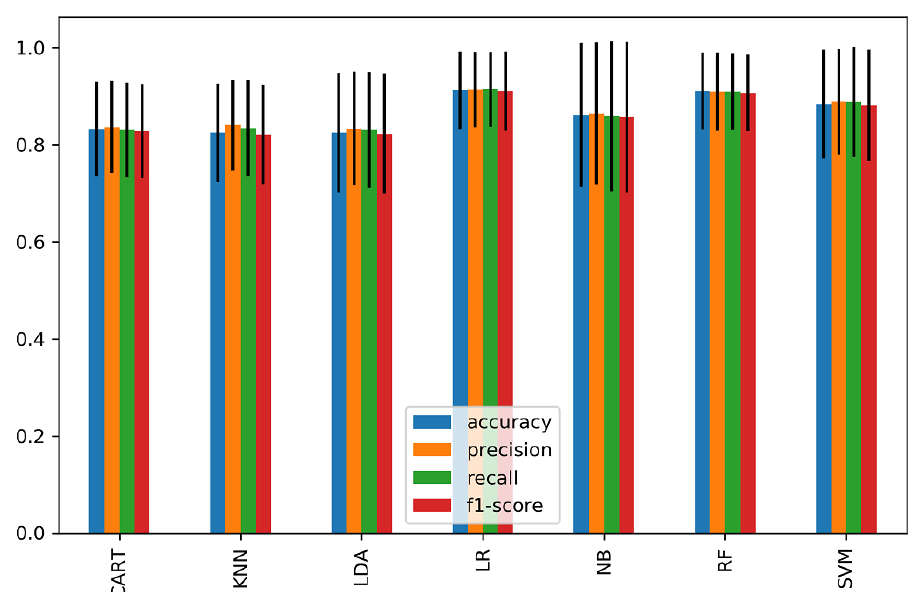
Figure 10. The average classification performance and standard deviation of all significant connectiv- ity network features of PLV.